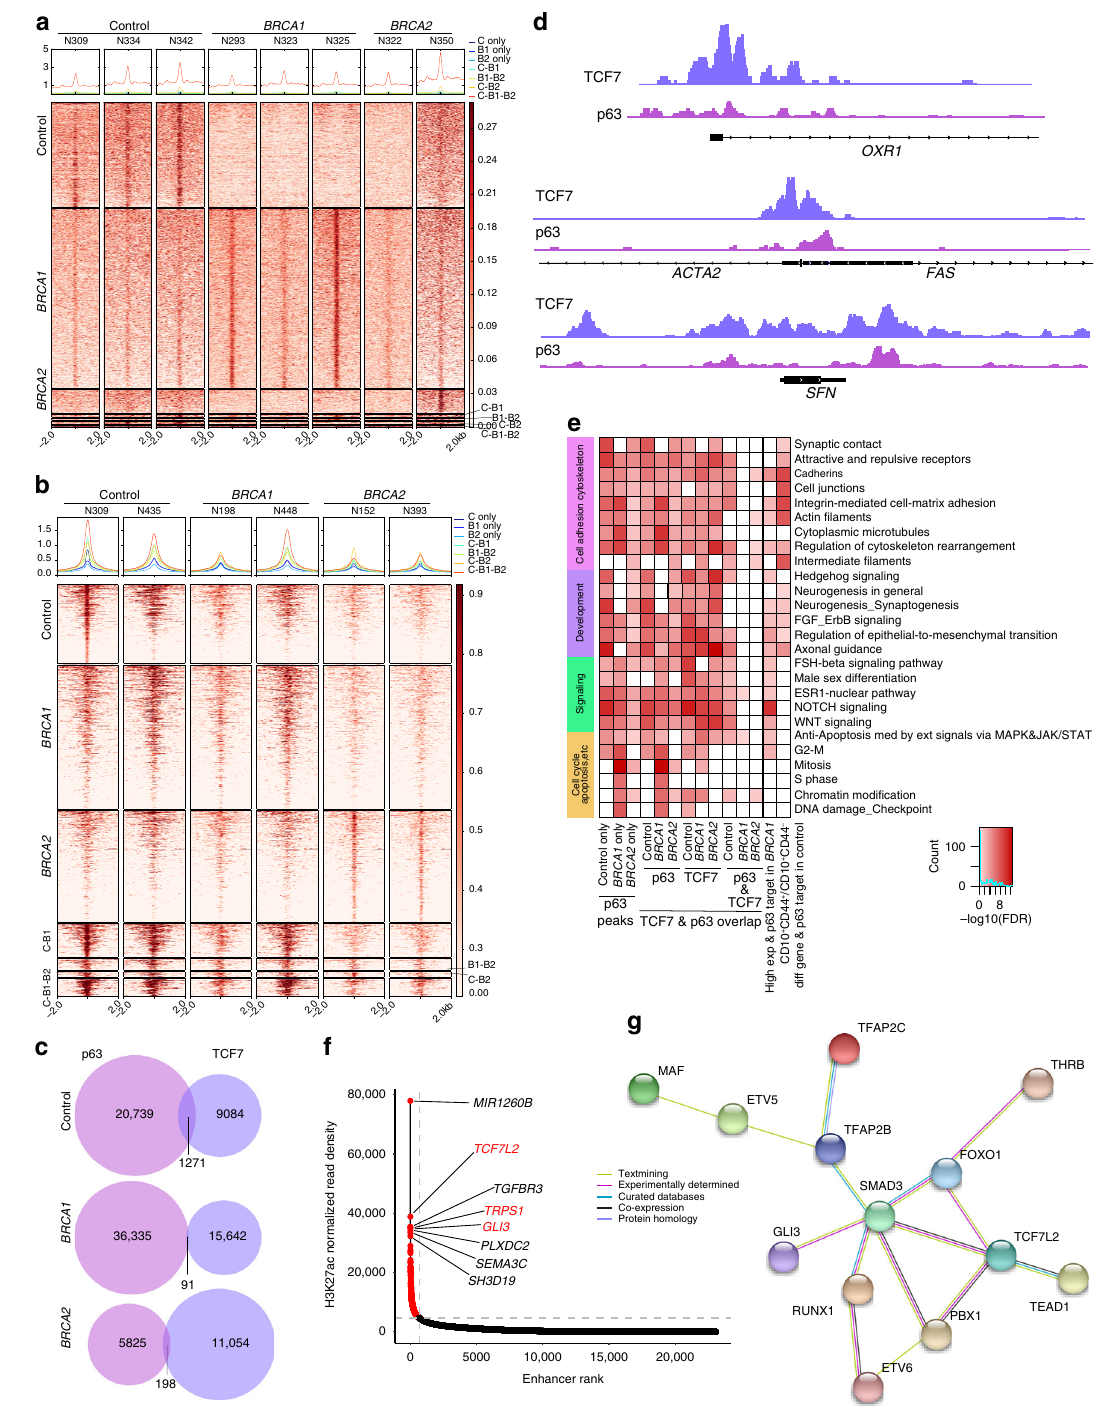
Fig. 3 p63 genomic targets of and enhancer landscape in myoepithelial cells. a , b Heatmap depicting p63 ( a ) and TCF7 ( b ) peaks which are unique in normal breast tissue of control women (C only), and BRCA1 (B1 only), and BRCA2 (B2 only) mutation carriers, and overlap between groups. The color key is the score of ChIP-seq signal over selected genomic region, the signals across different genomic regions have scaled to the same length. c Overlap between p63 peaks and TCF7 peaks in control women, BRCA1 and BRCA2 mutation carriers. d Gene tracks depicting p63 and TCF7 signal at selected genomic loci. The x -axis shows position along the chromosome with gene structures drawn below, whereas y -axis shows genomic occupancy in units of rpm/bp. e Pathway-enrichment analysis of genes associated with p63 or TCF7 peaks in normal, BRCA1 , or BRCA2 myoepithelial cells or differentially expressed between the indicated cell types. Color scale corresponds to − log( p -value) of signi fi cance of enrichment, calculated by MetaCore enrichment analysis test. f Plot depicting super-enhancers in normal myoepithelial cells from control women. g Predicted protein interaction network of TFs identi fi ed as core transcriptional regulatory circuits in myoepithelial cells. Legend indicates the source of data used to determine interactions. TFs that are not part of the network were